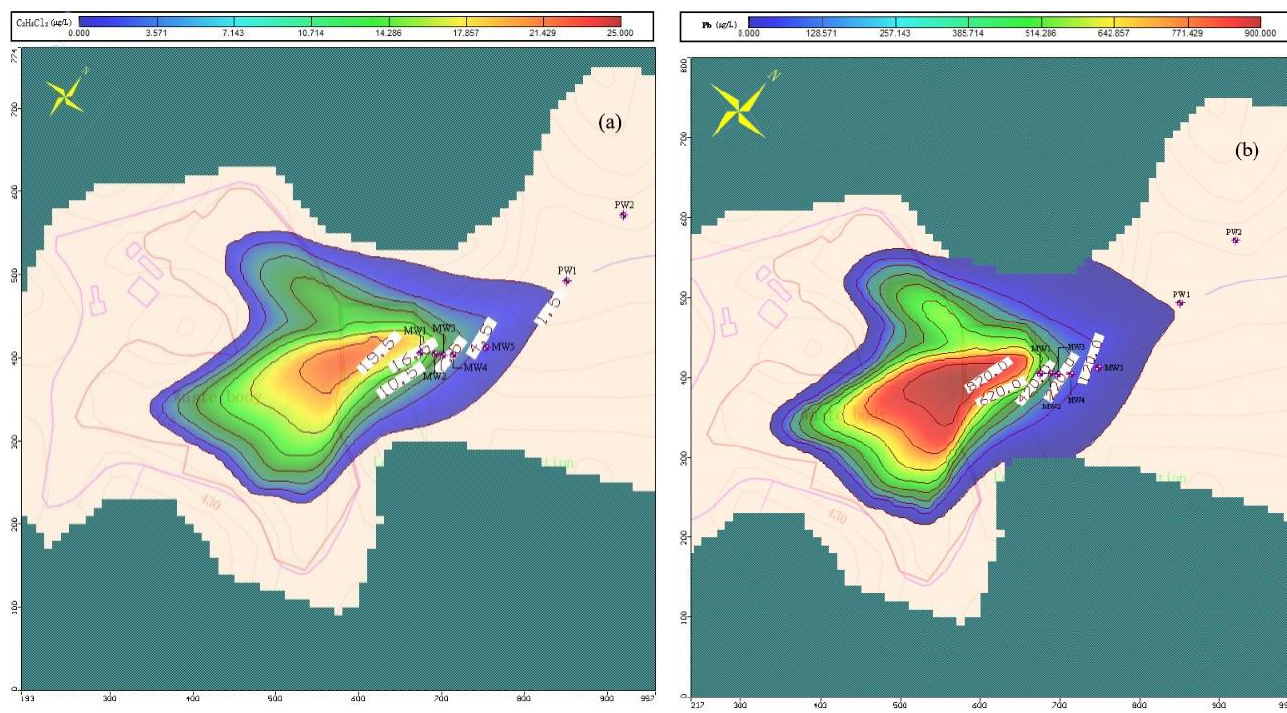
Figure 8. ( a ) Simulation result of spatial distribution of dichloroethane; ( b ) Simulation result of spatial distribution of Pb. Based on the simulation results, the non-carcinogenic risks caused by Mn, Pb, dichloroethane, chlorobenzene and chloroform and the total carcinogenic risks caused by dichloroethane, chlorobenzene and chloroform were calculated (Figure 9).